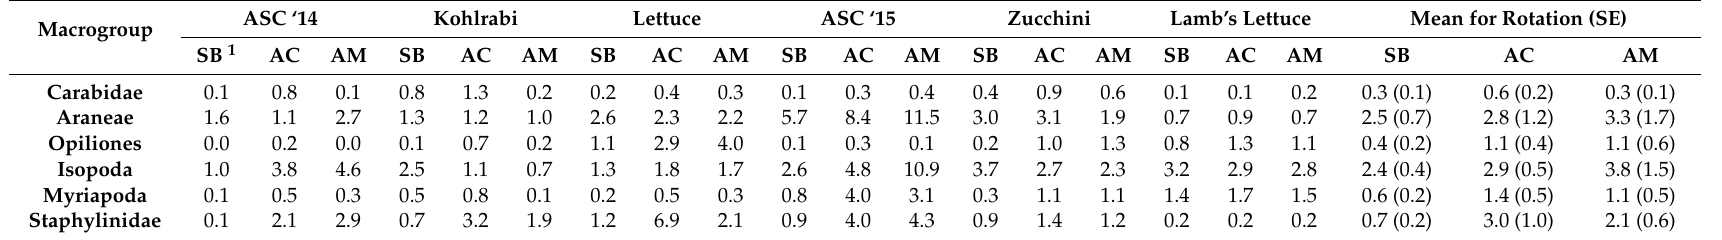
Table 8. Activity density of soil arthropods macrogroups for the three organic systems during the two-year rotation